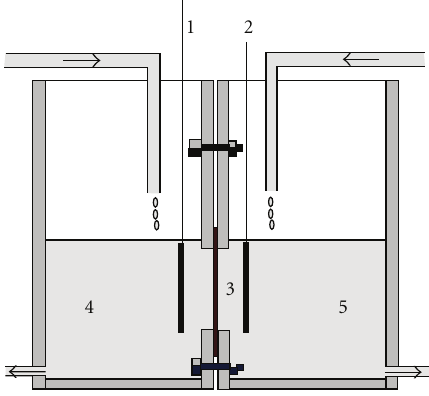
Figure 1: Simple schematic illustration of DBHFC (1) anode cat- alyst, (2) cathode catalyst, (3) the activated Nafion 117 membrane, (4) 1 M NaBH 4 +3M NaOH, and (5) 2M H 2 O 2 +0.5 M H 2 SO 4 .